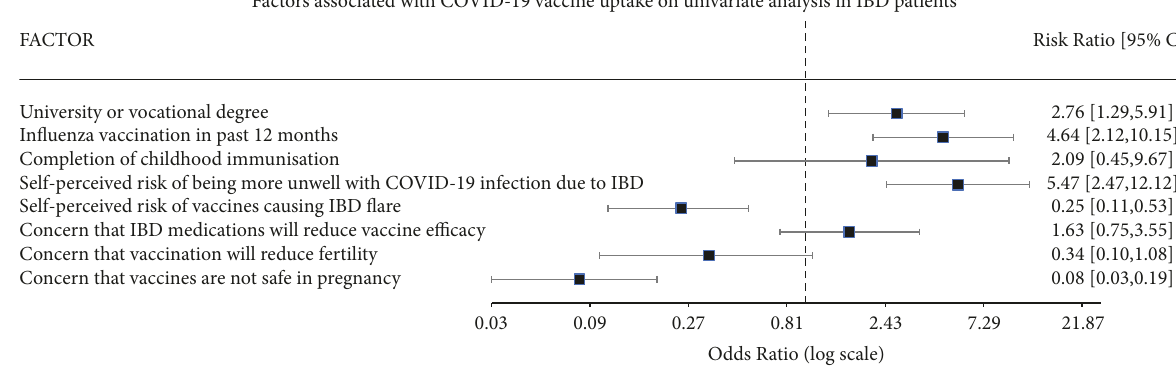
Figure 1: Factors associated with COVID-19 vaccine uptake on univariate analysis in IBD